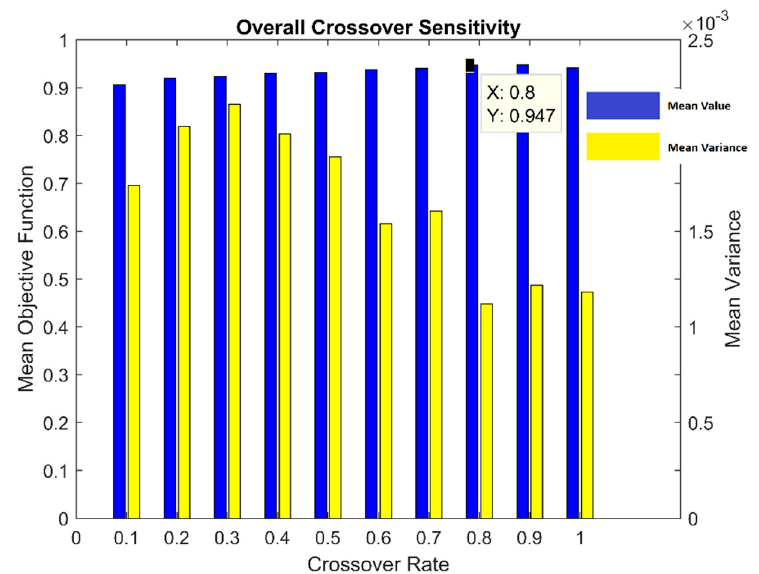
Figure 9. Sensitivity analysis of GA evaluating the crossover rate.